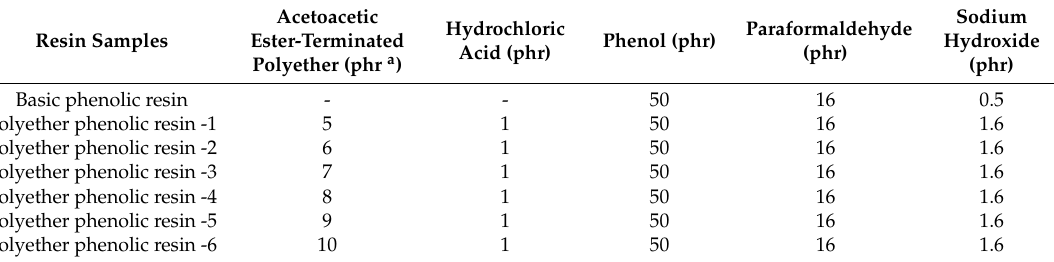
Table 1. The polyether phenolic resin synthesis